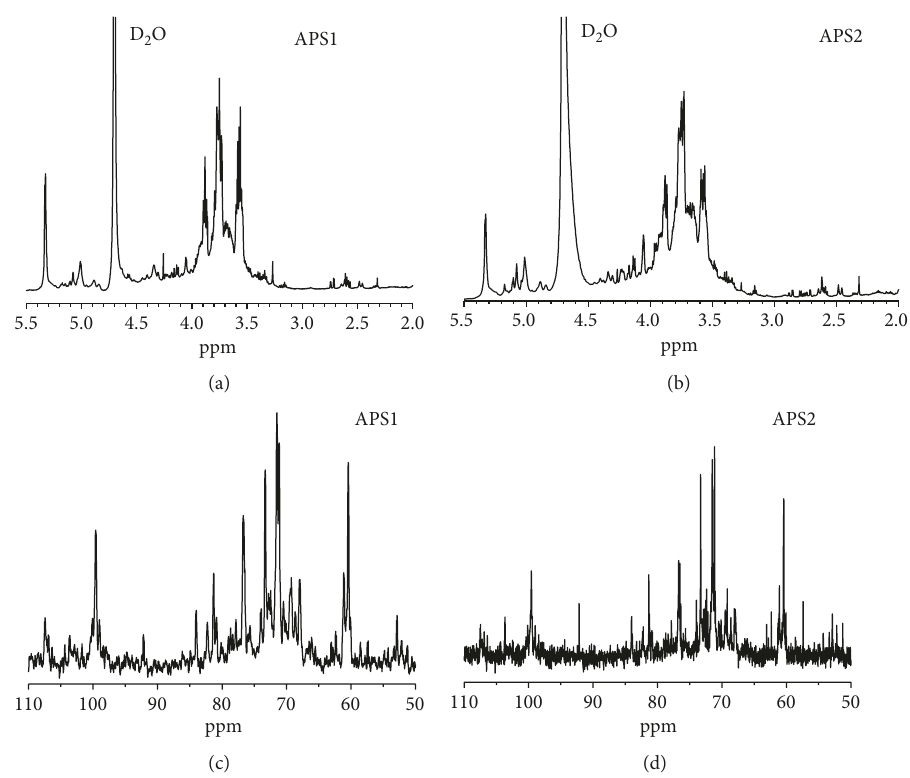
Figure 2: Nuclear magnetic resonance spectra of APS1 and APS2. (a) 1 H NMR spectrum of APS1; (b) 1 H NMR spectrum of APS2; (c) 13 C NMR spectrum of APS1; (d) 13 C NMR spectrum of APS2. Table 2: Structure characterization of APS1 and APS2 by 1 H NMR spectra.